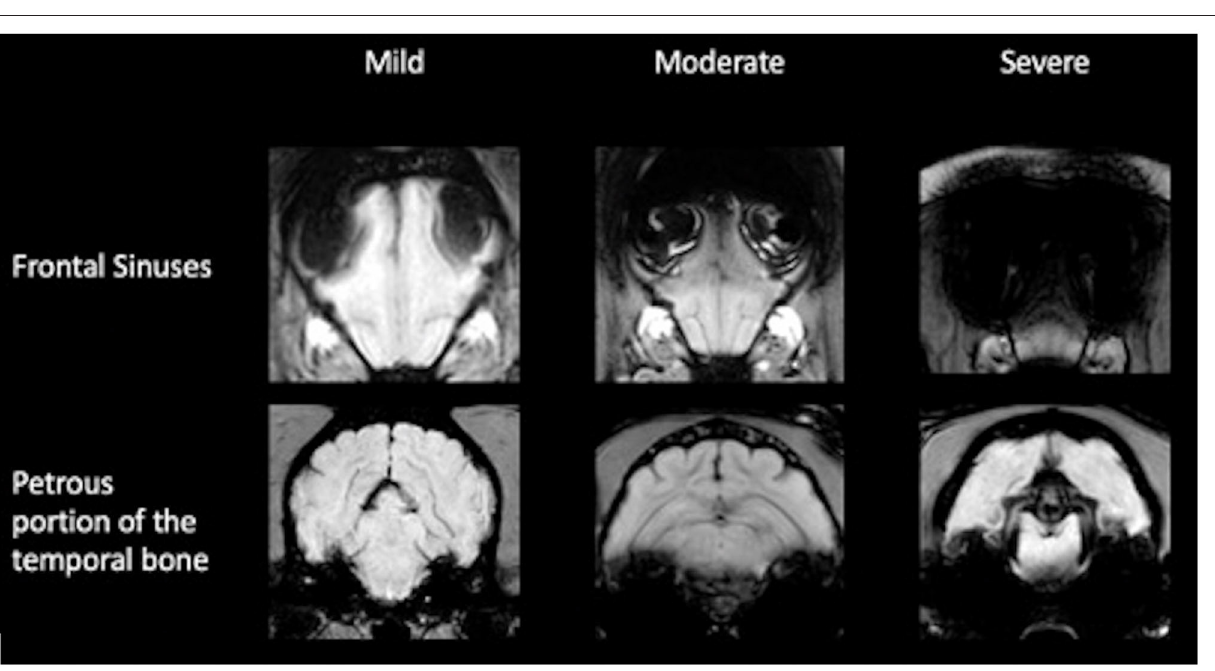
p = 0.157; > 15 kg, p = 0.327). No differences were found regarding the detection of lesions between T2 ∗ WI and SWI in the feline population when categorized by weight ( ≤ 5 kg, p = 1; > 5 kg, p = 0.180). additional CT examination (2 cats and 9 dogs). CT scans